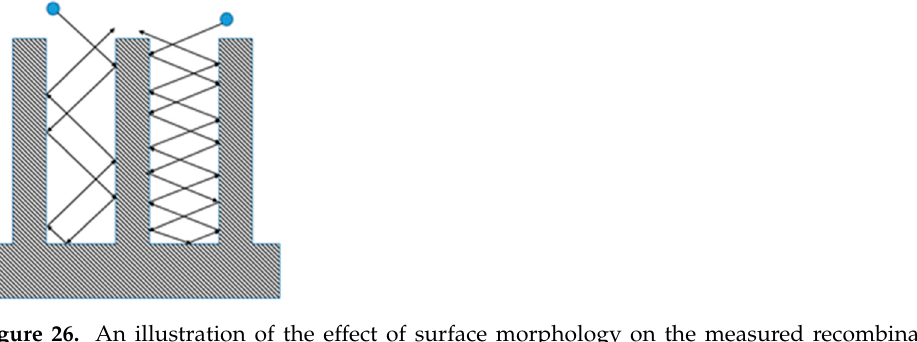
Figure 26. An illustration of the effect of surface morphology on the measured recombination coefficient. The arrows represent the path of atoms within the gaps in the approximation of elastic collisions with the walls.